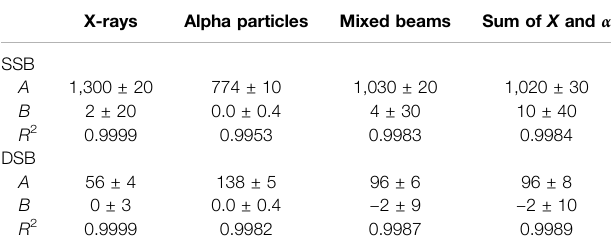
TABLE1| Dose – response fi ttingparametersforsimulatedSSBandDSBinduced by X-rays, alpha particles, and mixed beams. X-rays Alpha particles Mixed beams Sum of X and